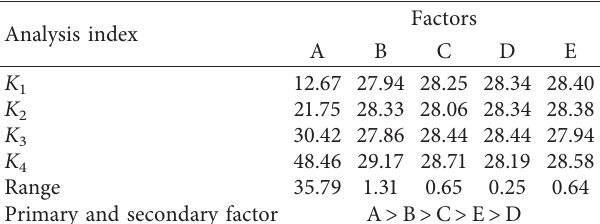
Table 11: Range analysis of the final setting time of slurry.